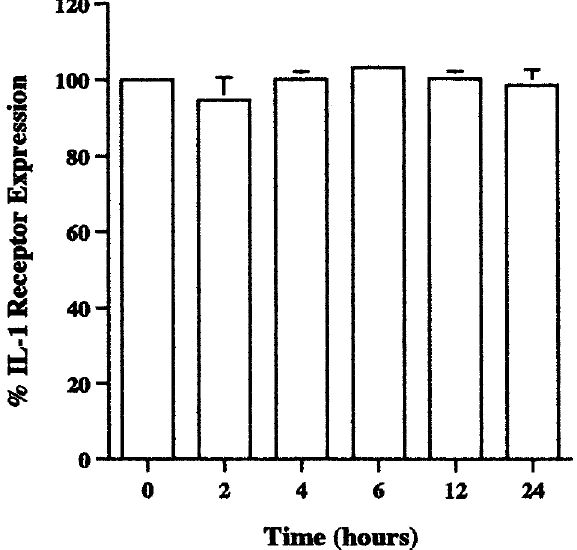
FIG. 3. Levels of IL-1 receptor, type I, in rabbit colonocytes treated with IL-1 (30ng/ml) for different time periods. No significant increase in the receptor levels was observed at any of the times tested. Data are means±SE for four separate